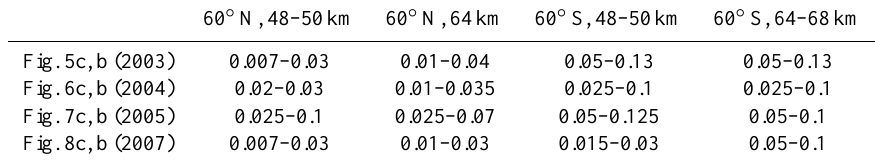
Table 2. Amplitudes of the 5-day ozone perturbations (ppmv) at 48–50km and 64–68km, at 60 ◦ N and 60 ◦